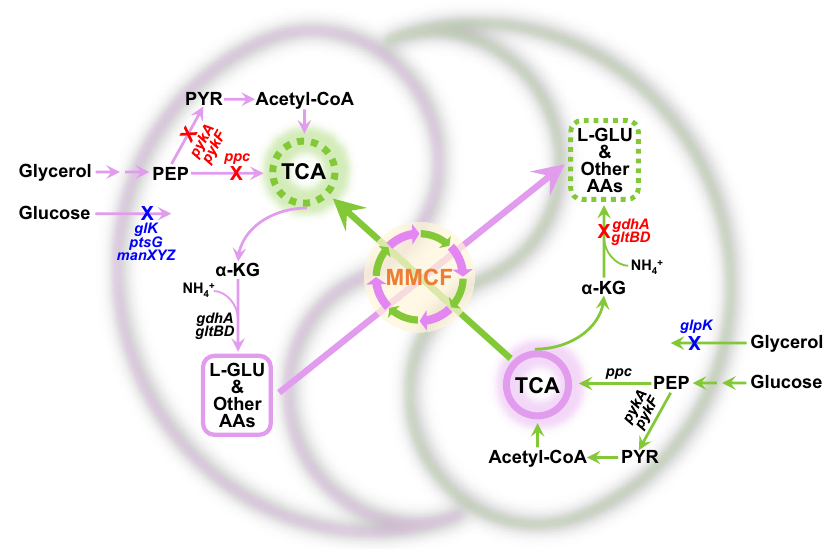
Fig. 1 Design principles of the stable coculture system. The two strains are engineered to utilize glycerol and glucose, respectively, and cross-feed each other with amino acids and the TCA cycle intermediates. Blue crosses denote gene knockouts to block glucose/glycerol utilization; red crosses denote gene knockouts to block glutamate biosynthesis and the TCA cycle. MMCF multi-metabolite cross-feeding. Genes: glK encodes glucokinase, ptsG encodes PTS glucose transport protein, manXYZ encodes mannose permease, pykA/F encodes pyruvate kinase, ppc encodes phosphoenolpyruvate carboxylase, glpK encodes glycerol kinase, gdhA encodes glutamate dehydrogenase, gltBD encodes glutamate synthase. Metabolites: PEP phosphoenolpyruvate, PYR pyruvate, α -KG α -ketoglutarate, L-GLU L-glutamate, AAs amino acids.